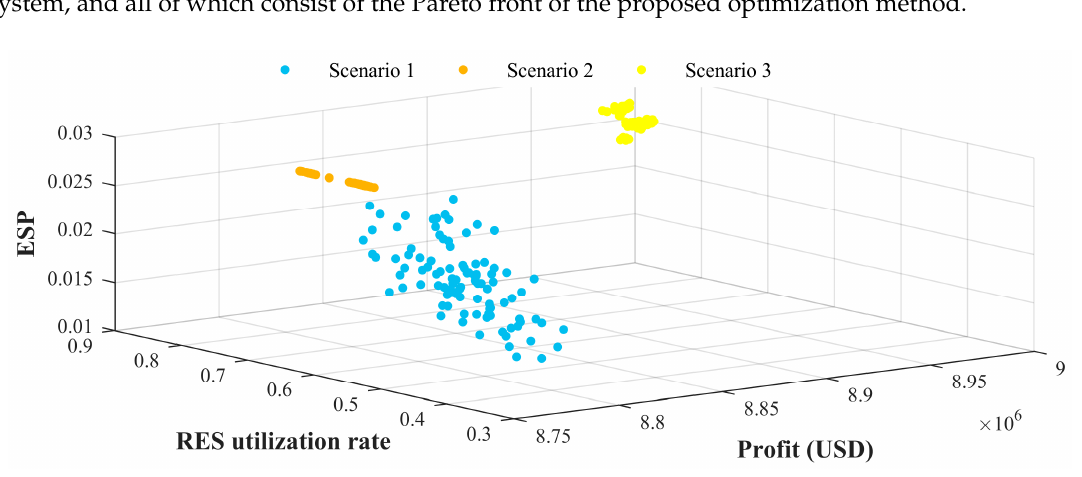
Figure 15. Optimization result of Case B.